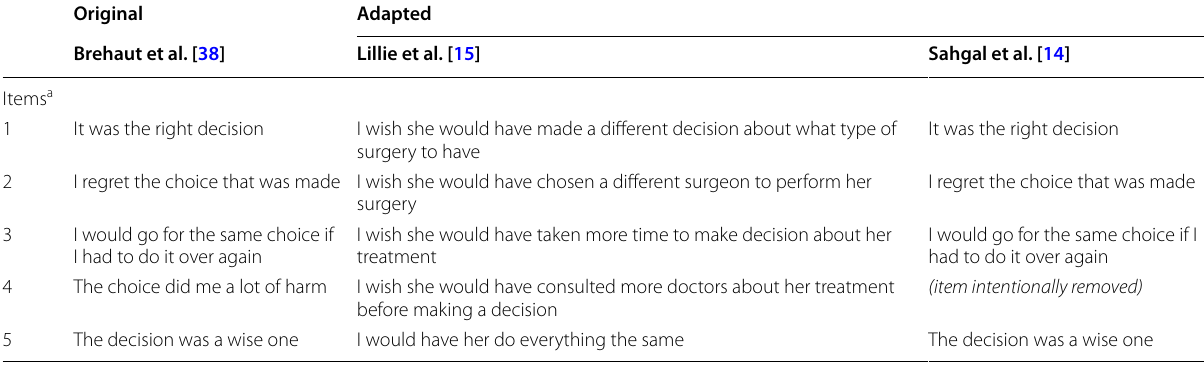
Table 3 Decisional Regret Scale, original and adapted